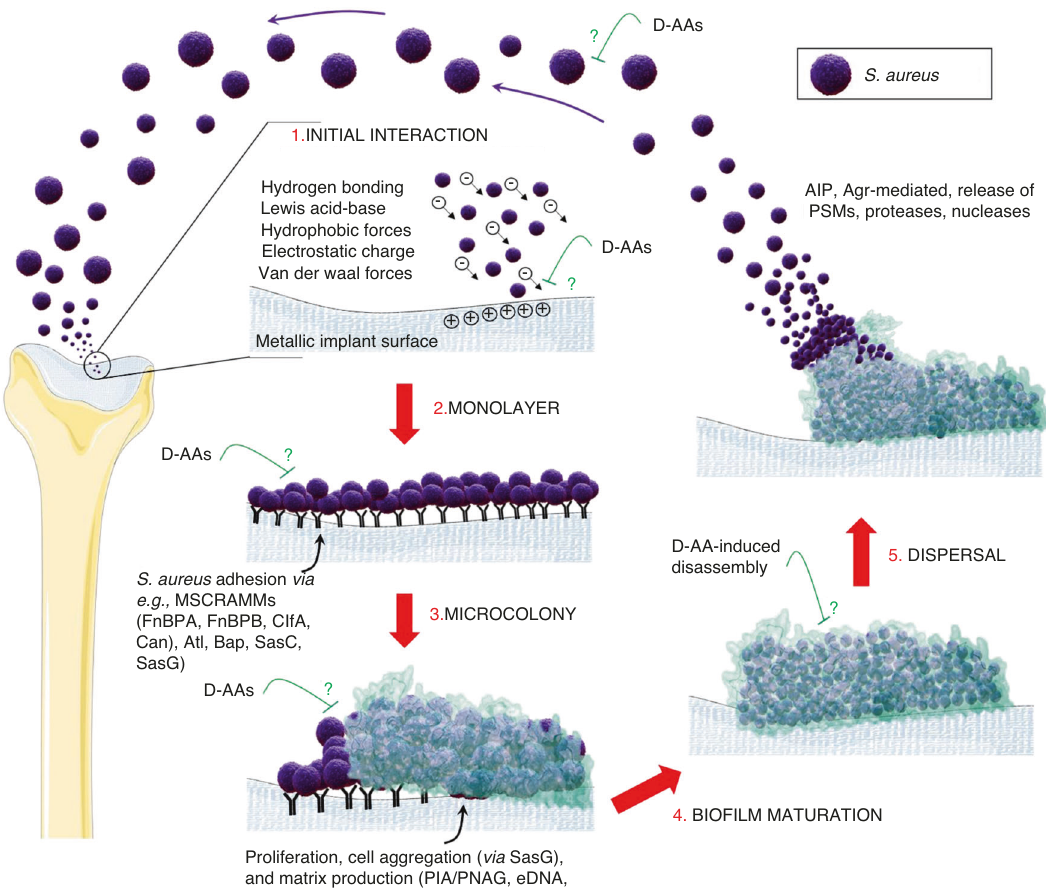
Fig. 5 An example schematic showing the life cycle of S. aureus bio fi lm formation as follows: (1) adhesion to an abiotic surface, (2) the development of a monolayer, (3) microcolony formation, (4) bio fi lm maturation, and (5) dispersal. Initial S. aureus adhesion is reversible via van der Waals forces, gravitational forces, surface electrostatic charge, hydrophobic interactions, Lewis acid – base interactions, and hydrogen bonding. S. aureus surface adhesion occurs via recognition of adhesive matrix molecules (MSCRAMMs), including FnBPa, FnBPB, and ClfA, by microbial surface compounds and via cell surface proteins, e.g., Bap, SasC, SasG, and Atl. D-AAs may be able to inhibit initial adhesion, reduce cell adhesion ef fi ciency, and block bacterial attachment and growth from the foci of the monolayer. Robust aggregations composed of eDNA, amyloid fi bers, polysaccharide intercellular adhesin/poly-ß (1-6)-N-acetylglucosamine (PIA/PNAG), polysoluble modulins (PSMs), and other proteins are formed. Some D-AAs may prevent this cell ‒ cell adhesion, leading to structural complications in the mature bio fi lm. During maturation, activated Agr-mediated quorum sensing (QS) initiates bio fi lm matrix modulation, and the EPS matrix is fully developed. QS can be activated either through PSM production or protease activation. PSMs maintain bio fi lm structure, and persister cells develop. D-AAs may interfere at this stage by incorporating into the peptidoglycan bond, inhibiting protein binding to the cell wall and disrupting cell ‒ cell and cell-surface interactions, thereby disassembling bio fi lm structure in areas of high concentration and/or preventing protein synthesis that is necessary for bio fi lm maintenance. This may enhance the effects of antibiotics. During dispersal, Agr-mediated QS initiates the dispersal of a segment of bio fi lm cells. This action is dependent on cell density signal molecules, namely, autoinducers. Autoinducing peptide (AIP) binds and activates histidine kinase (AgrC), which in turn phosphorylates AgrA. AgrA activates the transcription and production of a regulatory RNA molecule that impacts cell ‒ cell adhesion. This involves the release of PSMs, proteases and nucleases that aid dispersion. When the segment of cells becomes detached from the bio fi lm, they become planktonic and repeat the cycle, thereby infecting distant sites. During this phase, D-AAs may be capable of decreasing the metabolic activity and growth of planktonic